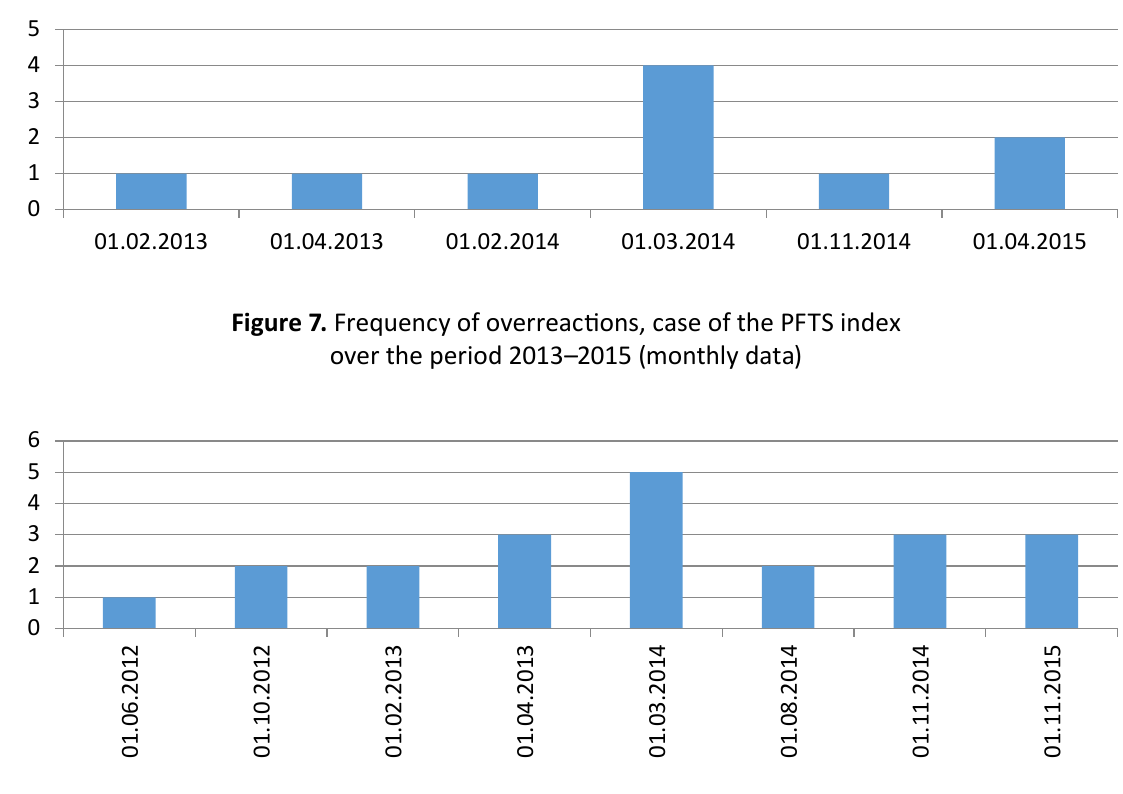
Figure 8. Frequency of overreactions, case of the “blue chips”